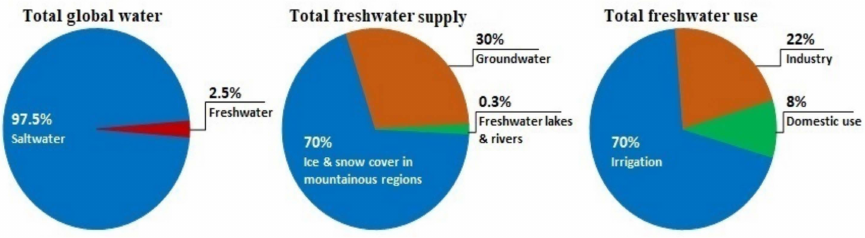
Figure 1. Information about global water and global supply and use of freshwater according to UN-Water “everythingconnects.org/fresh-water (accessed on 25 December 2022)”.